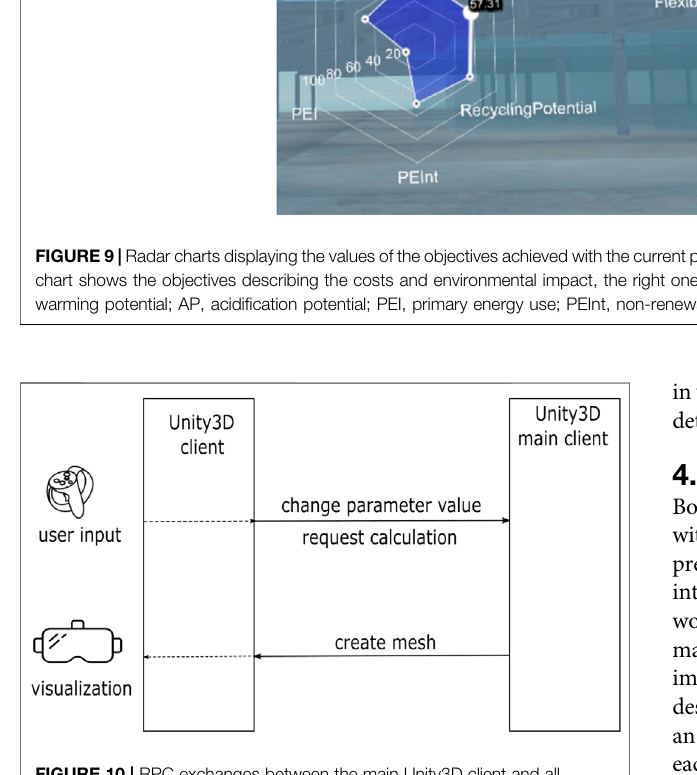
Frontiers in Virtual Reality |